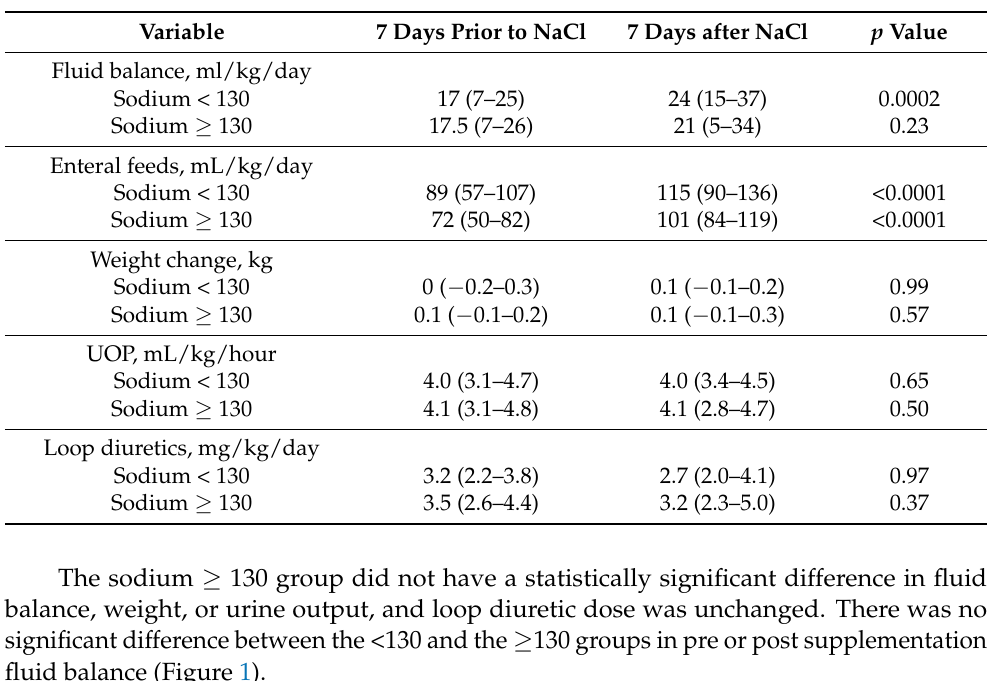
Table 3. Fluid balance and diuretic need based on plasma sodium level.